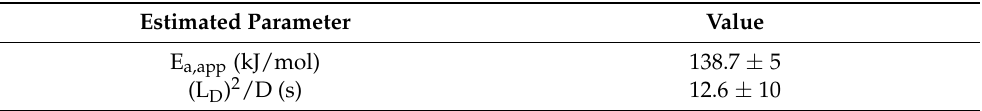
Table 6. Estimated parameters with their 95% confidence interval for the regression of the conversion data for n -hexane cracking over